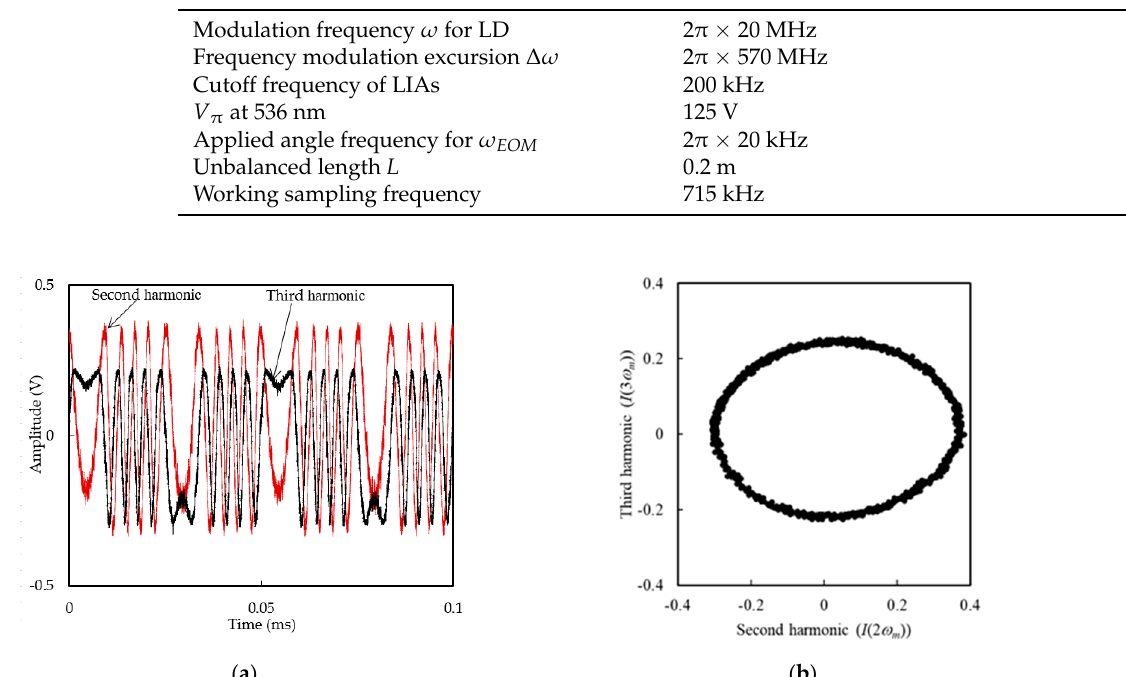
Figure 2. Harmonic detection : ( a ) second and third harmonics; ( b ) Lissajous diagram using I 2 ω and I 3 ω harmonics.